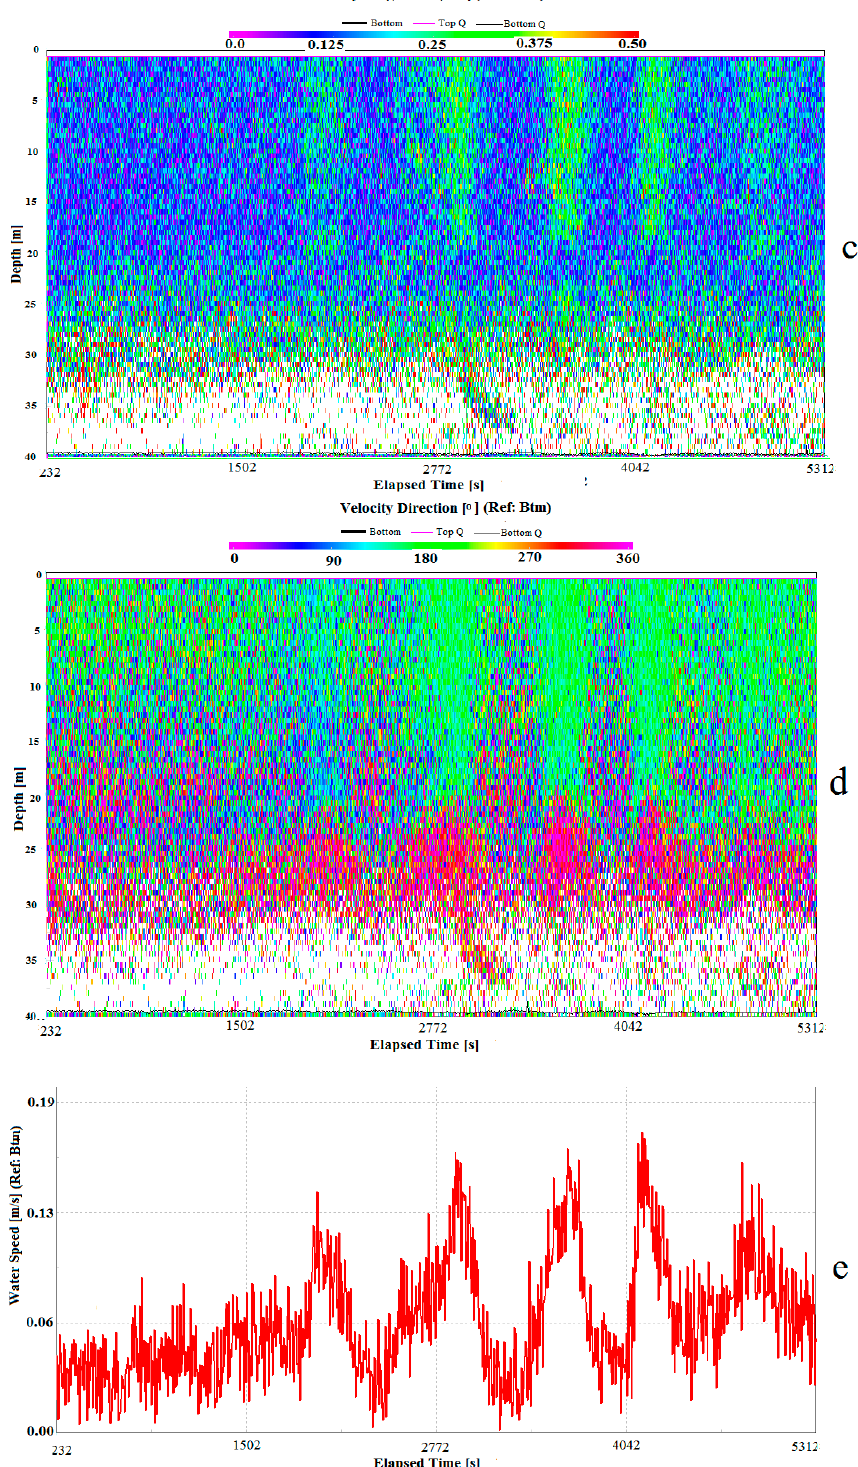
Figure 2. ADCP data from a train of internal waves under an anchored boat: ( a ) the echolocation signal (intensity of acoustic backscatter); ( b ) the vertical component of the current; ( c ) the magnitude; ( d ) the direction of the current; and ( e ) the curve of oscillations of the water column current velocity under the boat, caused by passing internal waves.